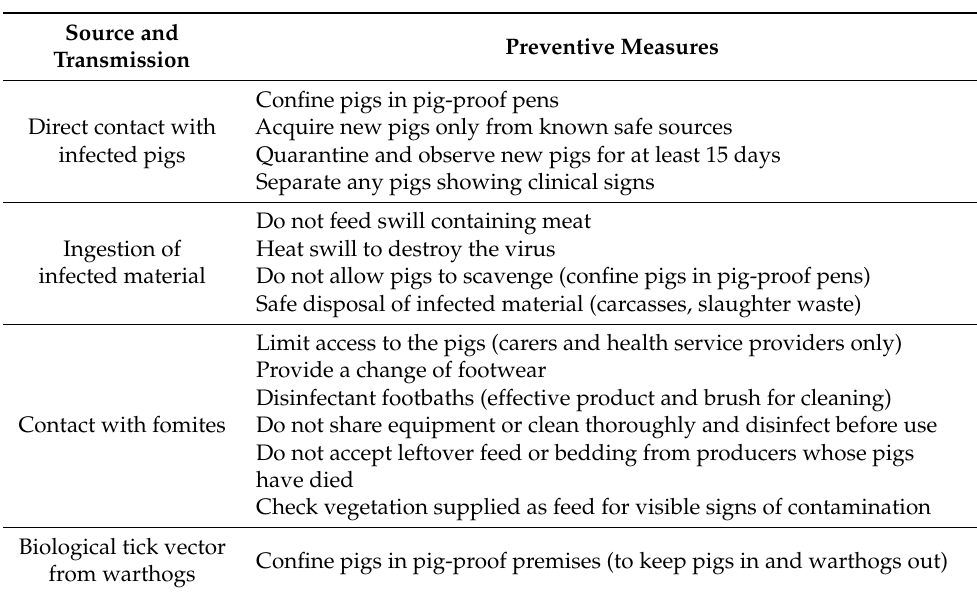
Table 2. Biosecurity measures recommended to prevent common transmission routes based on the authors’ experience and knowledge of the disease